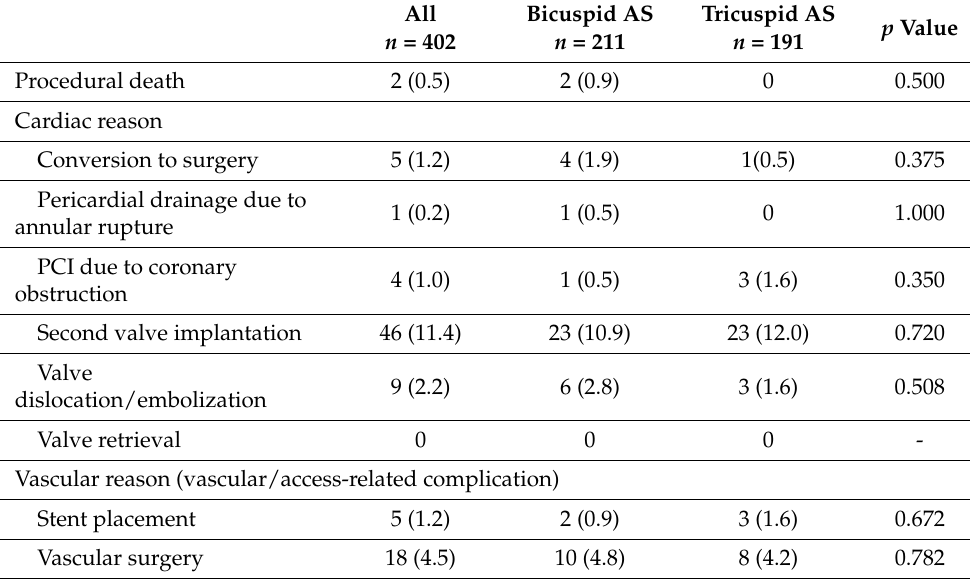
Table 4. Reasons for Technical Failure.